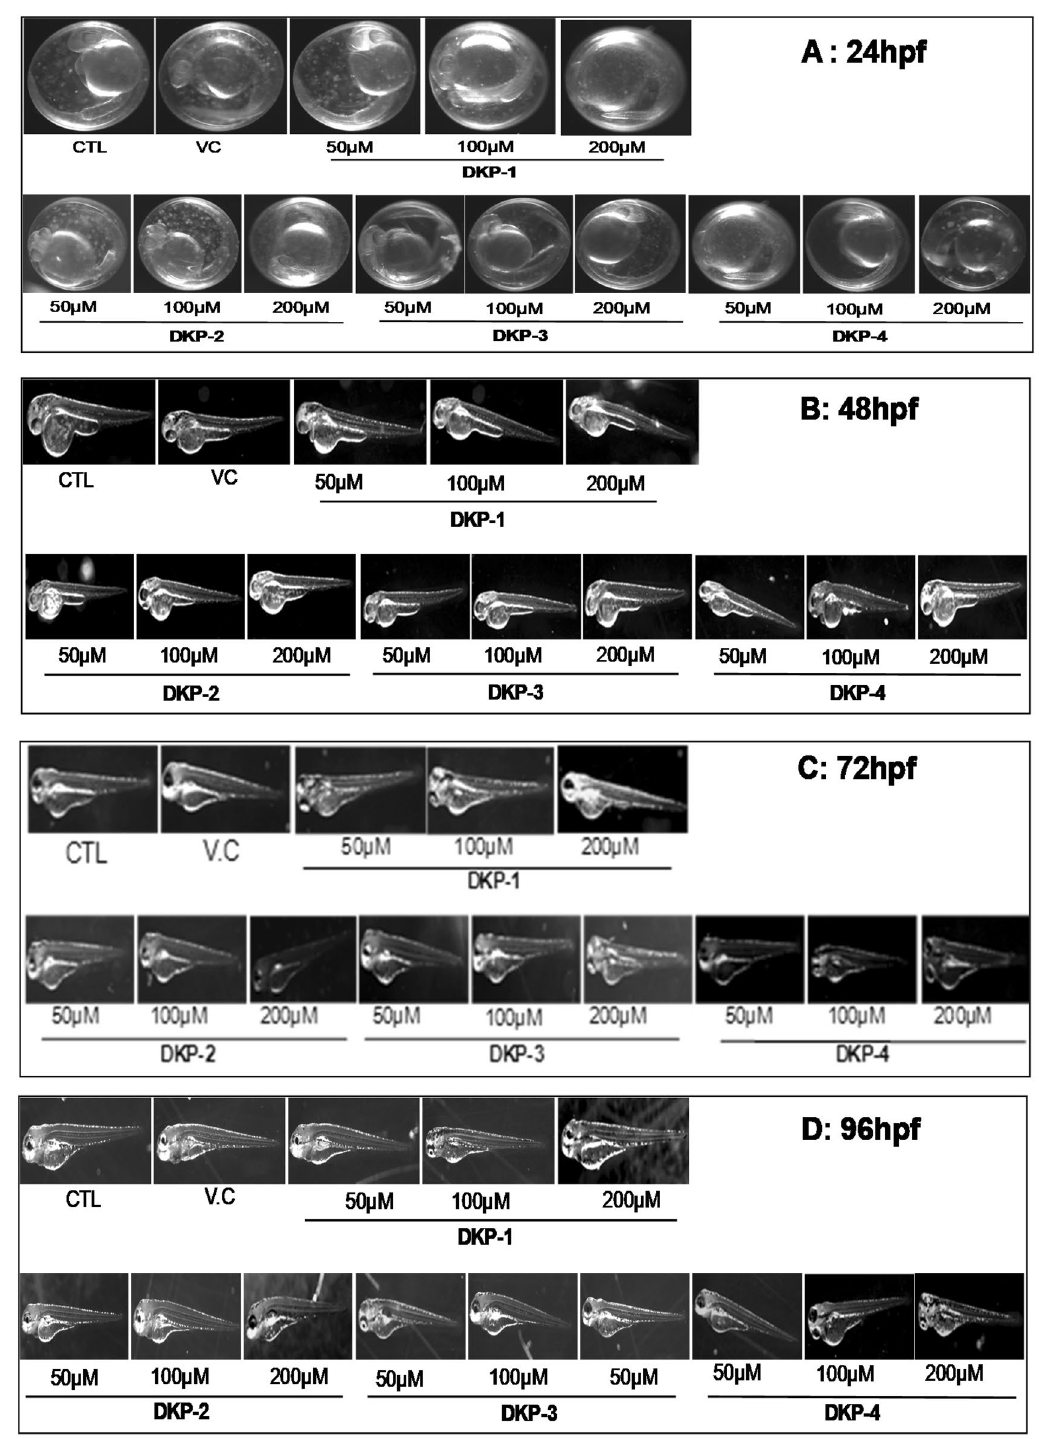
Figure 6. Developmental changes in the zebrafish embryos after treatment with different doses of four cyclic dipeptides. Representative images for 24 hpf ( A ), 48 hpf ( B ), 72 hpf ( C ), and 96 hpf ( D ). CTL Control, DMSO Vehicle control